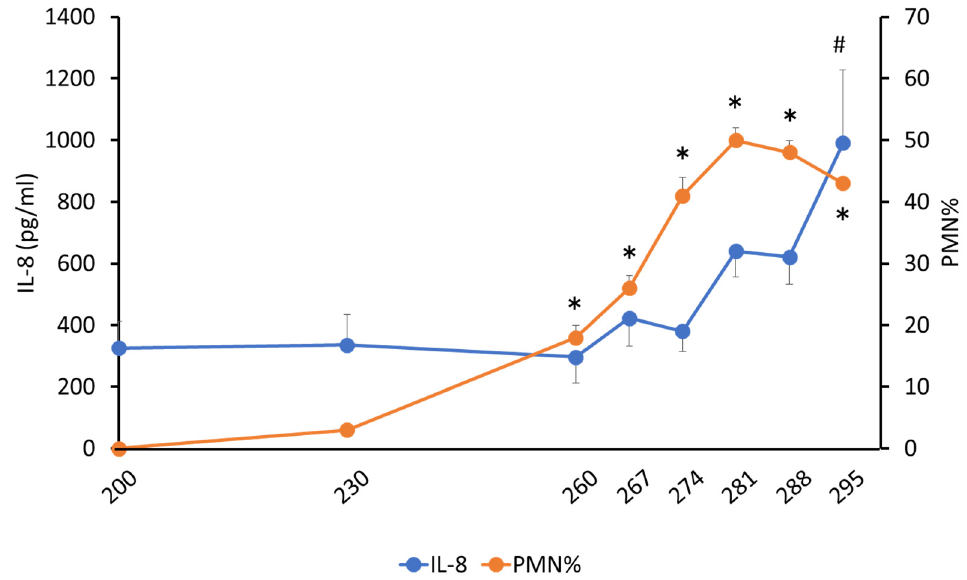
Figure 2. Interleukin-8 and polymorphonuclear neutrophil % in bovine cervical mucus with days of pregnancy. # p < 0.05 compared with 200 days in IL-8; * p < 0.05 compared with 200 days in PMN%.